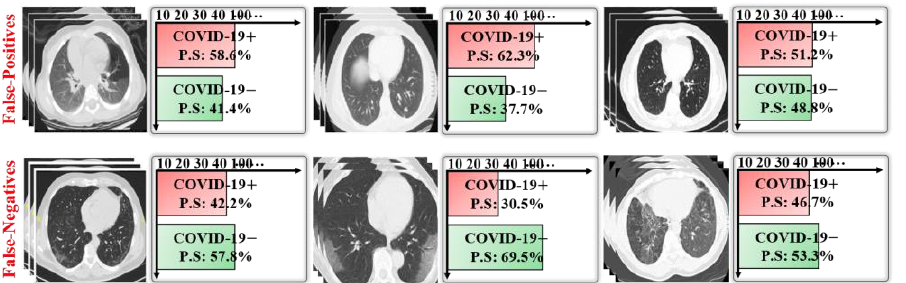
14 of 16 Figure 7. Visualization of predicted outputs of the proposed framework for given data samples in- cluding COVID- 19 negative and positive cases (“P.S: Prediction score”). Figure 8 shows a few samples of misclassified testing cases together with their pre- dicted scores. The existence of identical lesion shapes in COVID-19 negative and positive datasets may cause these incorrect predictions (false-negative and false-positive cases). Furthermore, inadequate data annotation might lead to incorrect predictions. However, medical specialists can reduce these inaccuracies by visually assessing the projected out- puts (i.e., prediction score and best-matched retrieved cases). Despite the substantial per- formance of the proposed diagnostic framework, there are drawbacks to the proposed CAD approach that might affect its overall efficacy in a clinical context. The main concern